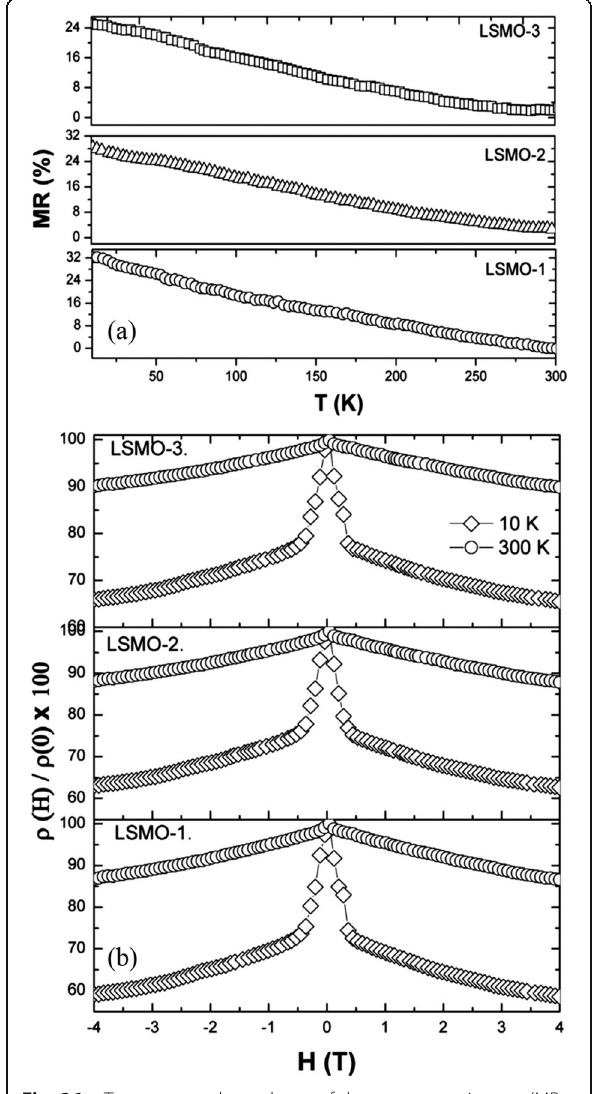
Fig. 26 a Temperature dependence of the magnetoresistance (MR %) at 1 T. b Normalized resistivity as a function of the applied field at 10 K and 300 K of the La 0.7 Sr 0.3 MnO 3 (LSMO) nanoparticles. LSMO- 1, -2, and -3 particles with average particle sizes of 20 nm, 23 nm, and 26 nm, respectively. Reproduced with permission of